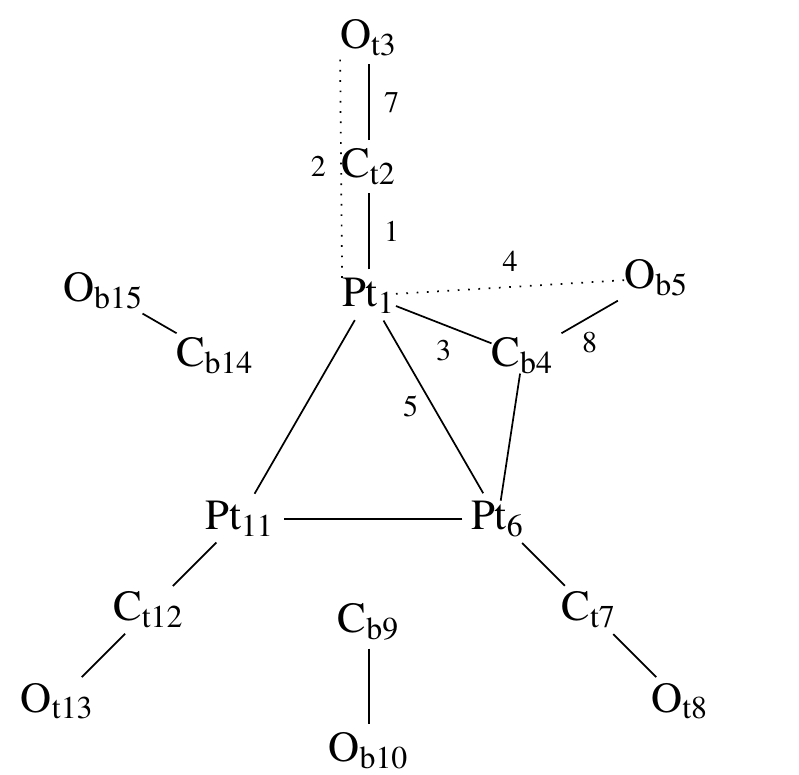
Figure 2. Atom indices within each Pt 3 (CO) 6 stack, used throughout the description of DIs. Indices of other stacks in dimers and in the nano-wire are incremented by 15, the number of atoms in each stack. Pair type 6 involve Pt atoms of different Pt 3